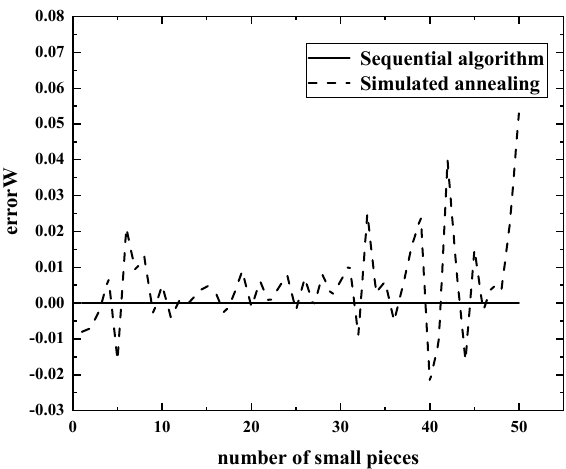
Figure 11. Comparison of errorW.